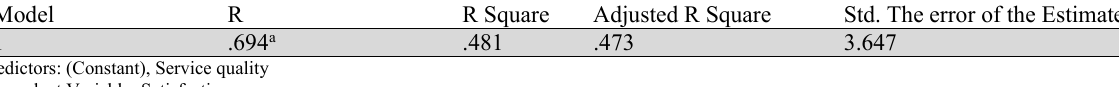
Coefficient of Determination Test